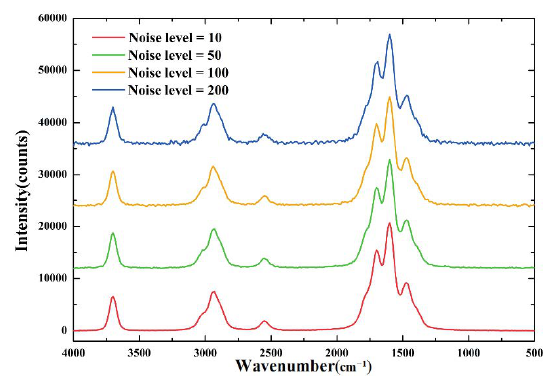
Figure 5. Four simulated spectra with different noise levels. Coatings 2022 , 12 , x FOR PEER REVIEW